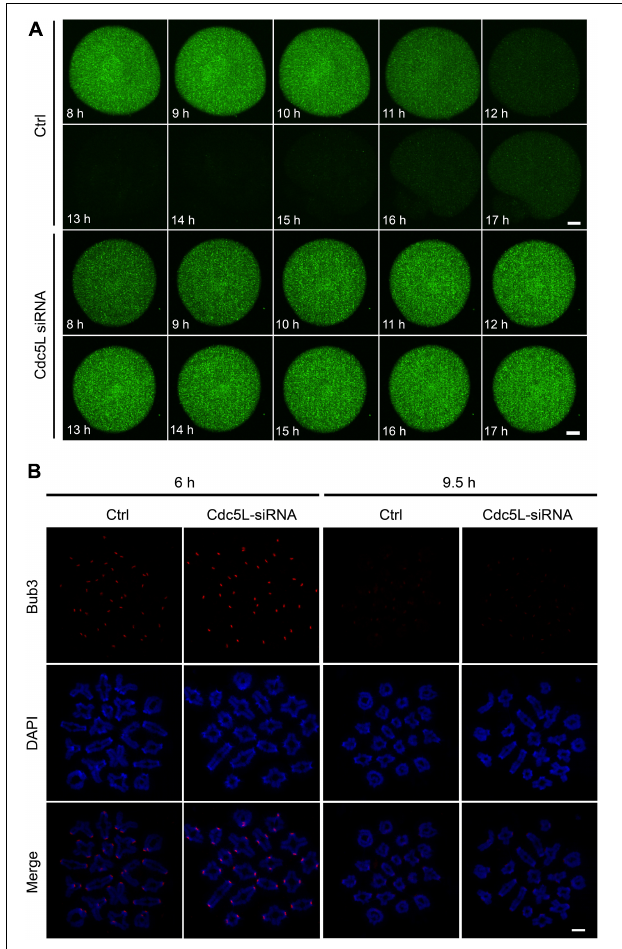
FIGURE 5 | Knockdown of Cdc5L does not affect normal function of SAC. (A) Time-lapse fluorescence measurement of CCNB1-EGFP after low concentration mRNA injection at GV stage. 20 ng/ µ l Ccnb1 - EGFP mRNA was used for injection. Oocytes were analyzed for each group as follows: Ctrl, n = 8; Cdc5L siRNA, n = 7. Scale bars: 10 µ m. (B) Chromosome spreads at 6 h (pro-Met I) (Ctrl, n = 8; Cdc5L siRNA, n = 10) and 9.5 h (Met I) (Ctrl, n = 17; Cdc5L siRNA, n = 21) after release from IBMX, then stained for Bub3 (red) and DAPI (blue). Scale bars: 5 µ